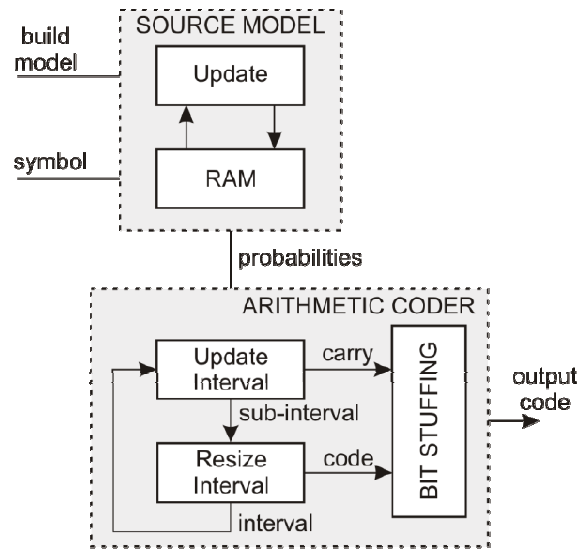
Figure 9. Hardware arithmetic